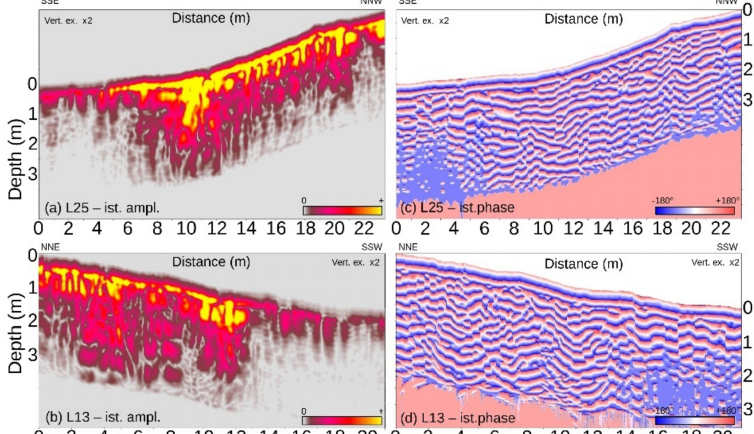
Figure 11. Instantaneous attributes of GPR profiles L25 and L13 of Figure 10; ( a ) instantaneous amplitude for L25, displaying the high reflective zones mainly in the first meter depth and in corre- spondence of cololite C3 at ~10 m; ( b ) instantaneous phase of profile L25, efficiently extending the interpretation depth and enhancing the reflections geometry and continuity highlighting undulated horizons of laterally variable thickness; ( c ) instantaneous amplitude for L13, displaying the laterally variable reflectivity located within the first meter depth, particularly between the distance interval 10–12 m; ( d ) instantaneous phase of L25, again displaying undulated geometries of shallow horizons whilst migration smiles are enhanced deeper; sub-vertical phase discontinuities (distance range 13–21 m) dissecting the shallow horizons within the high reflective